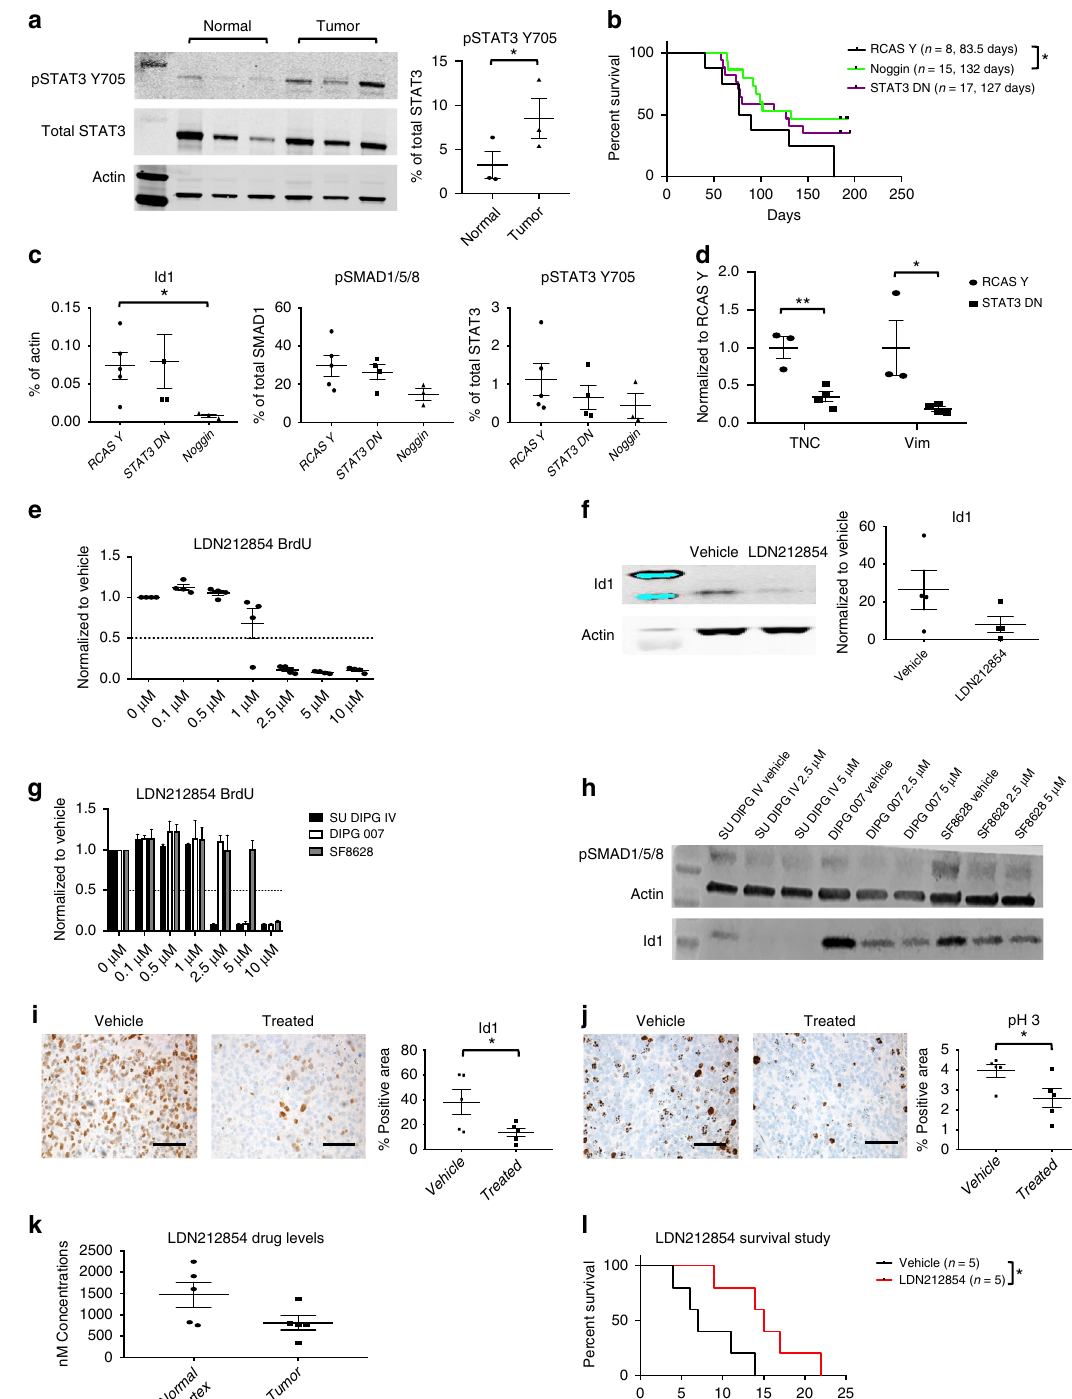
therapeutic strategy than targeting the STAT3 pathway for ACVR1 mutant DIPGs.